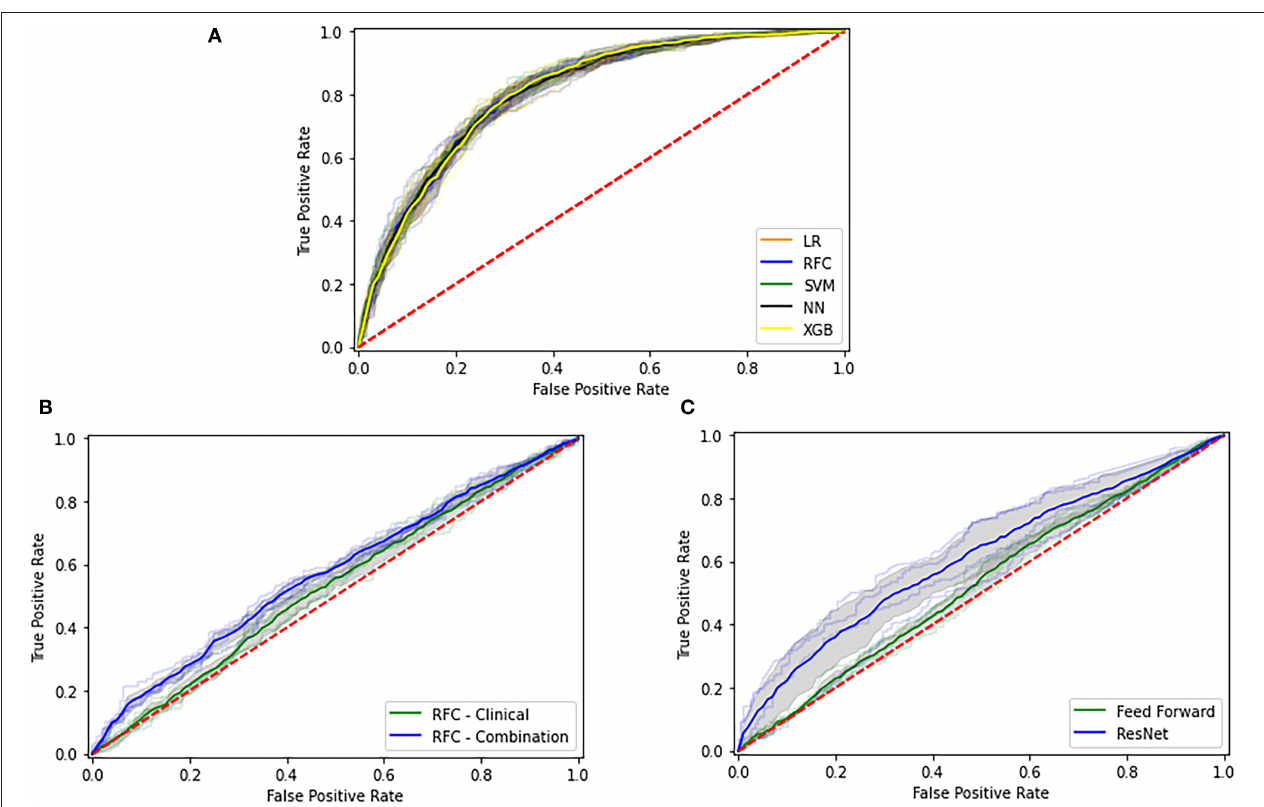
FIGURE 3 | Receiver operating characteristic (ROC) for the different experimental setups. (A) The modified Rankin Scale (mRs) prediction for the clinical experiment, (B) Modified Thrombolysis in Cerebral Infarction (eTICI) prediction using the radiomics data, and (C) eTICI prediction using deep